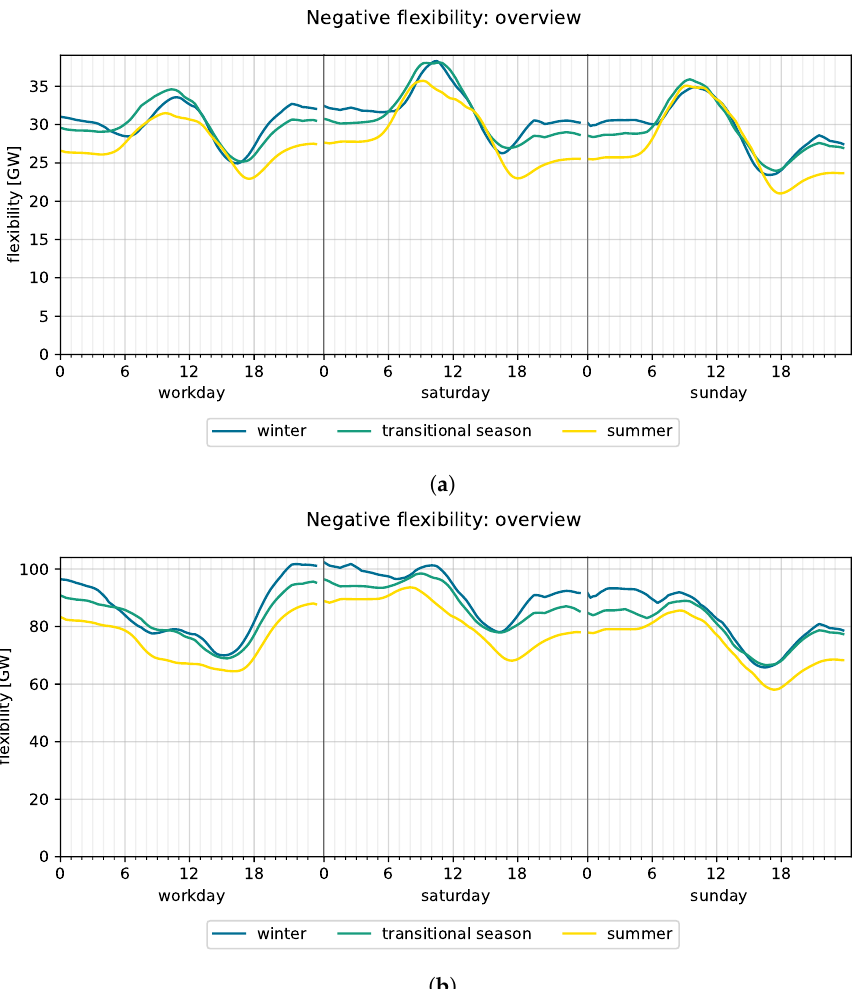
Figure 7. Comparison of the immediately available negative flexibility on the basis of the weighted scenario for the years ( a ) 2025 and ( b )